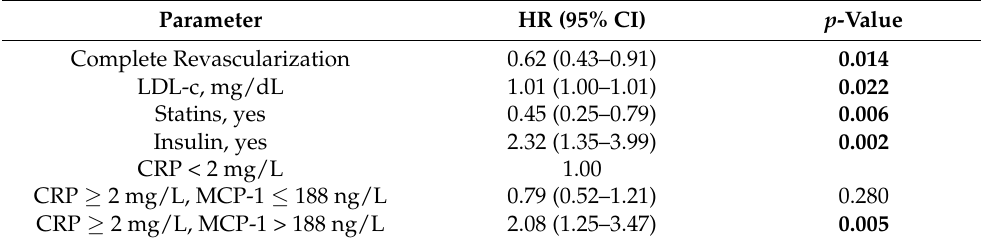
Table 3. Multivariate Cox proportional hazard model for the incidence of recurrent acute ischemic events in patients with